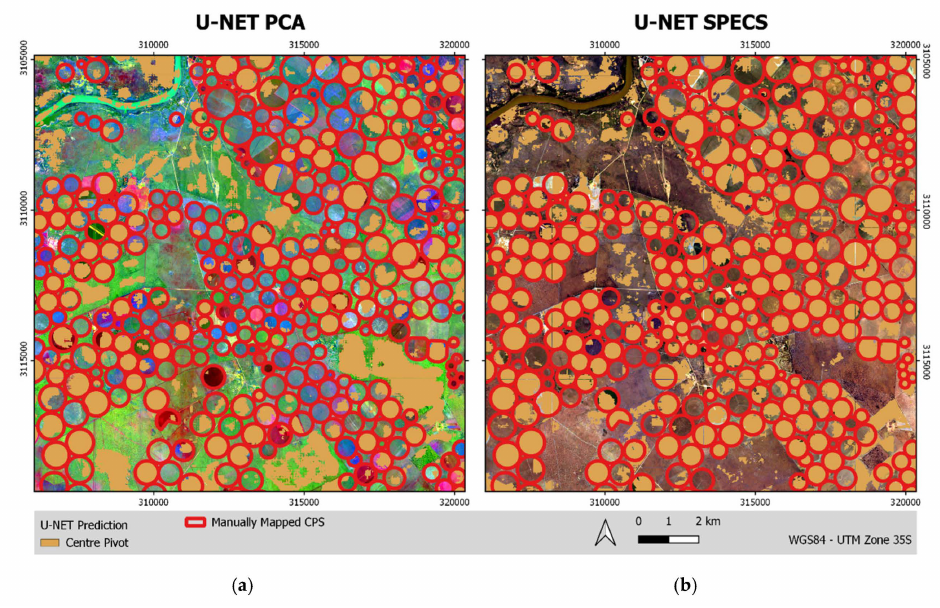
Figure 6. Semantic segmentation results (orange) of U-NET PCA ( a ) and U-NET SPECS ( b ) for the South African study area. The manually mapped CPSs are displayed in red. In addition, the first three principal components are shown for U-NET PCA and the Sentinel-2 bands 2, 3, and 4 for U-NET SPECS in the